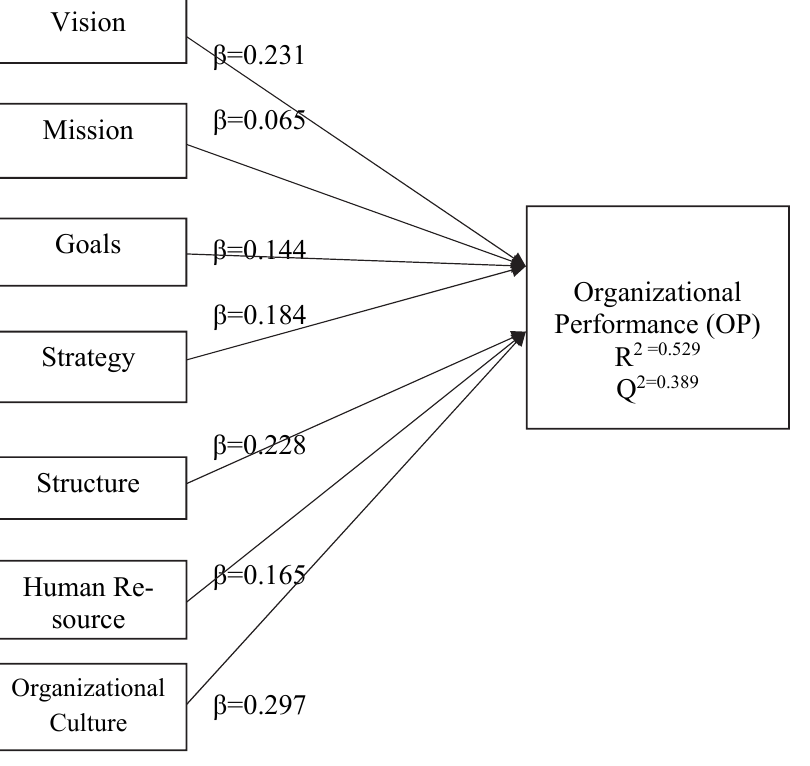
Fig. 1. Results of the Structural